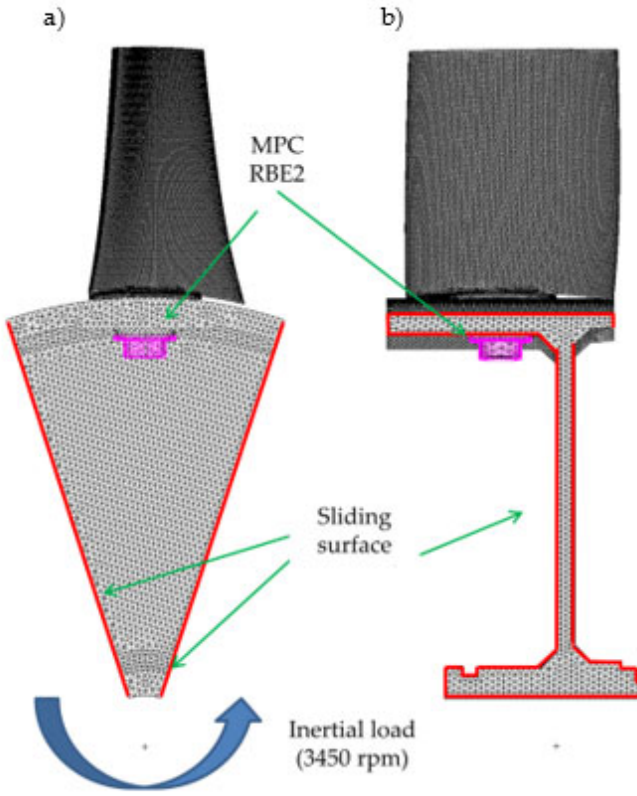
Figure 10. Boundary conditions of the computational model: front view ( a ), side view ( b ).